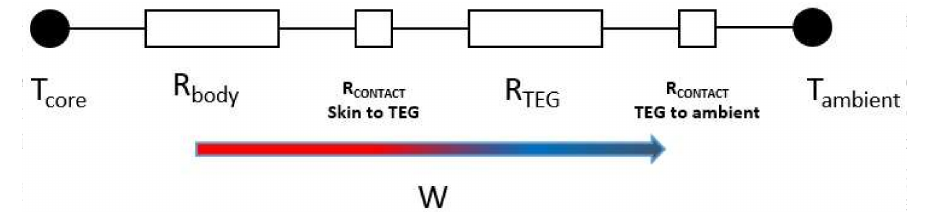
Figure 2. Thermal equivalent circuit of a TEG on human